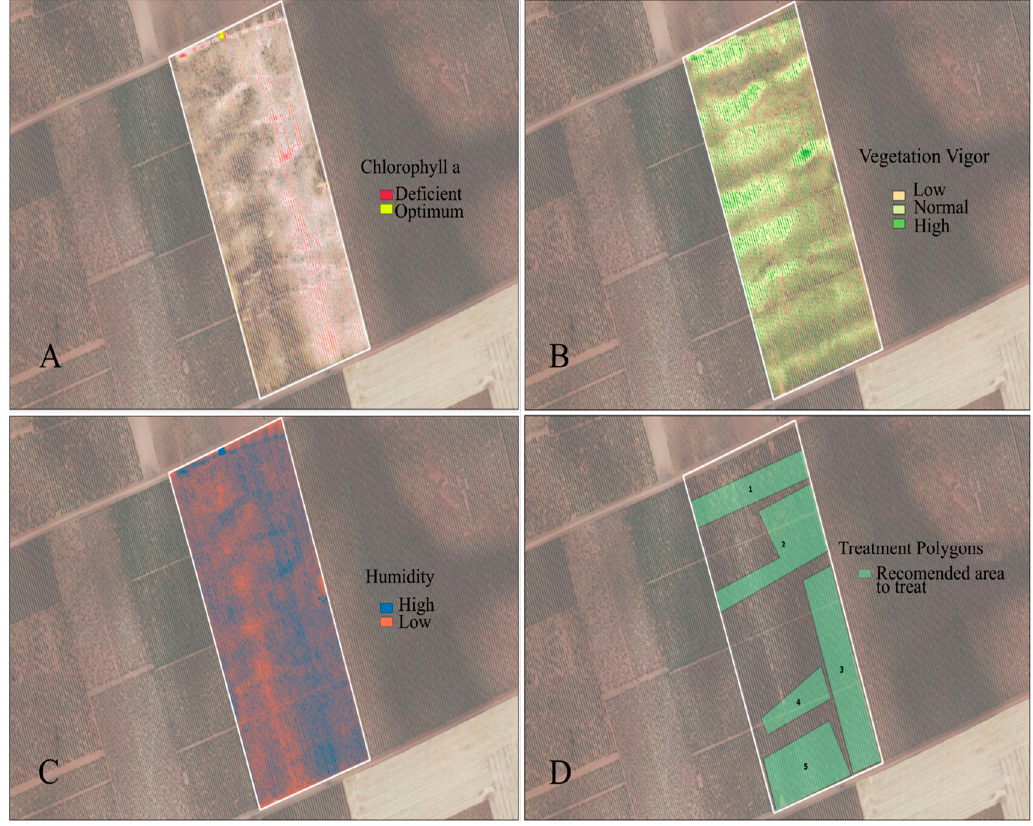
Figure 7. Drone generated maps for olive crop using QGIS. ( A ) Map for ‘chlorophyll a’ representation generated based on GNDVI. ( B ) Map for vegetation status generated based on NDVI. ( C ) Map for humidity contents of the crop generated based on NDWI. ( D ) Representation of recommended treatment zones in the crop field. (Images facilitated by MC Biofertilizantes).